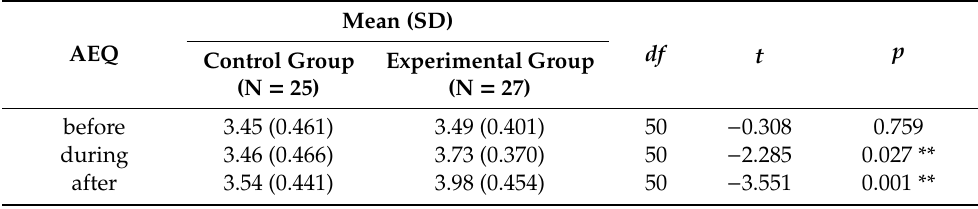
Table 7. The emotional manifestation before, during and after